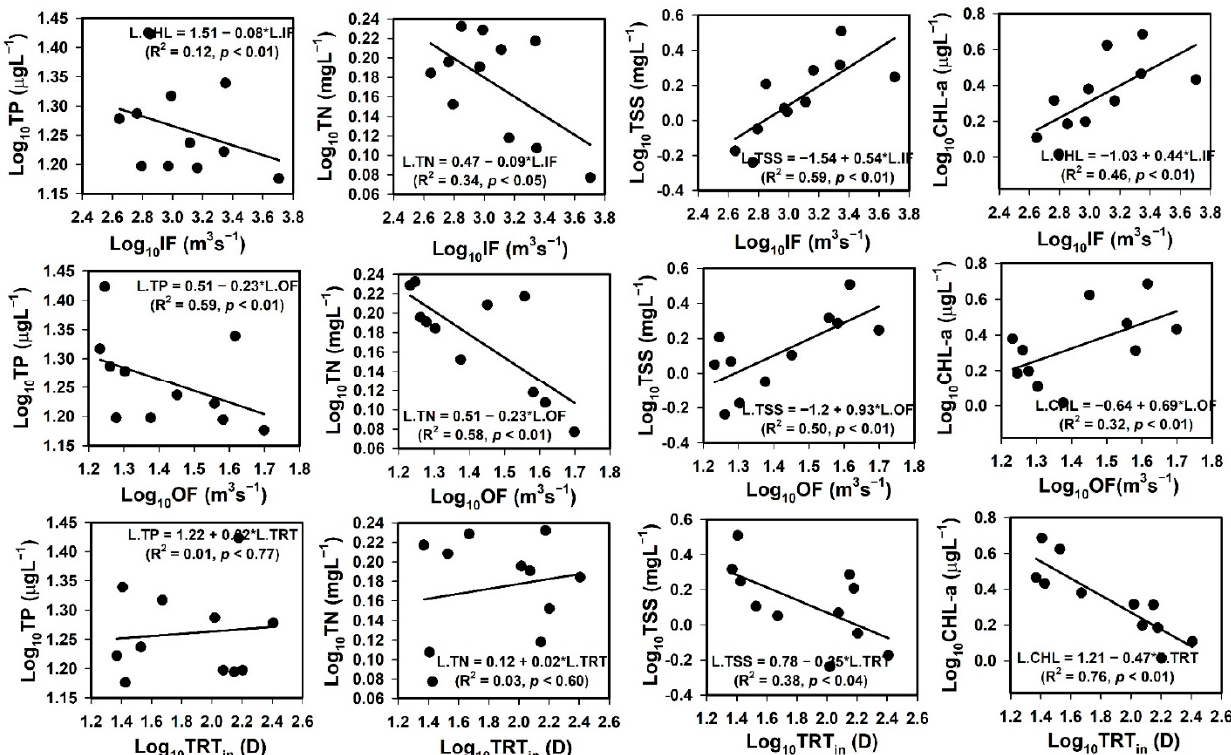
Figure 4. Relationships of TP, TN, TSS, and CHL-a, with inflow (IF), outflow (OF), and theoretical residence time inflow (TRT in ). TP: total phosphorus; TN: total nitrogen; TSS: total suspended solids, and Chl-a: chlorophyll-a.